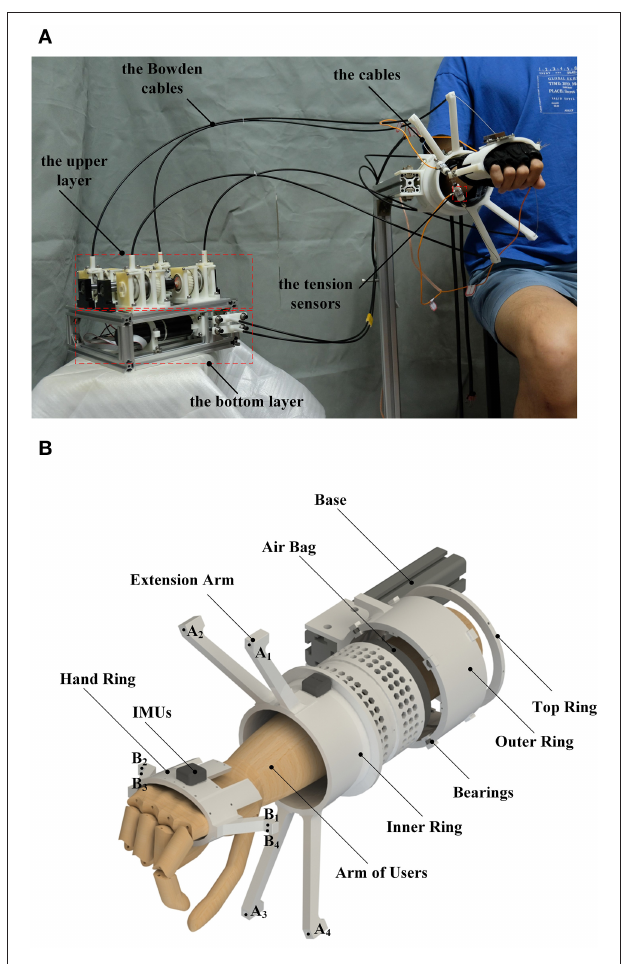
FIGURE 2 | (A) close-up of the robot on a healthy subject, (B) the exploded view of the robot: A 1 − 4 are four cable attachments of the forearm module, and B 1 − 4 are four cable attachments of the hand